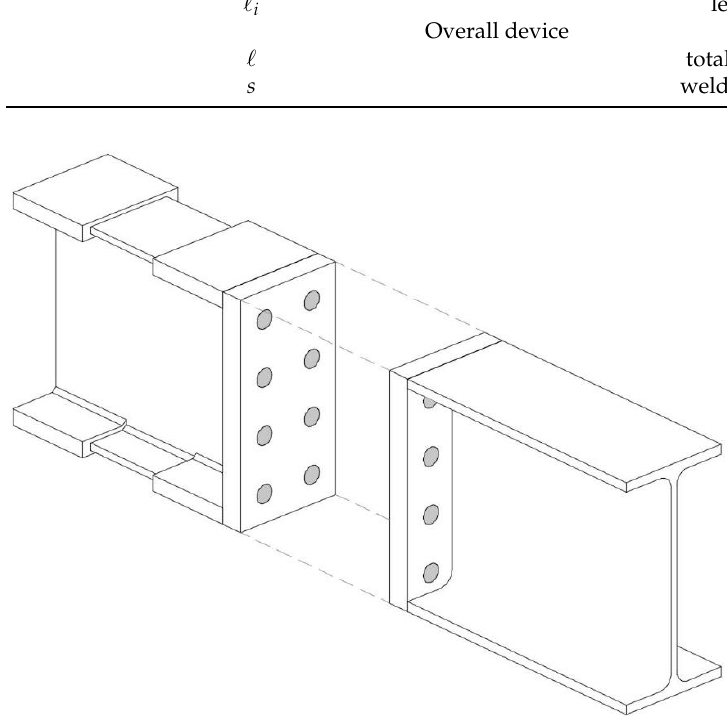
Figure 4. 3D view of the device and of the connection with the beam.